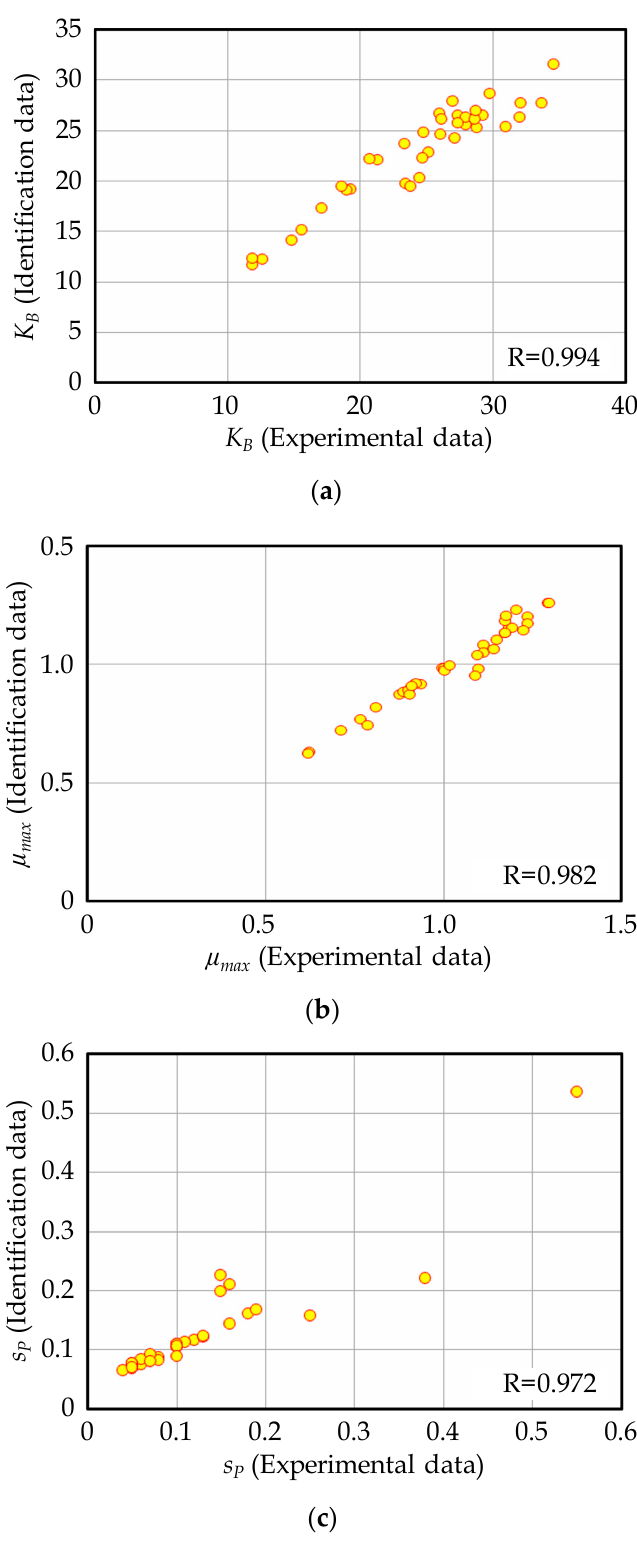
Figure 13. Identification results. ( a ) Identification result for K B . ( b ) Identification result for μ max . ( c ) Identification result for s P .